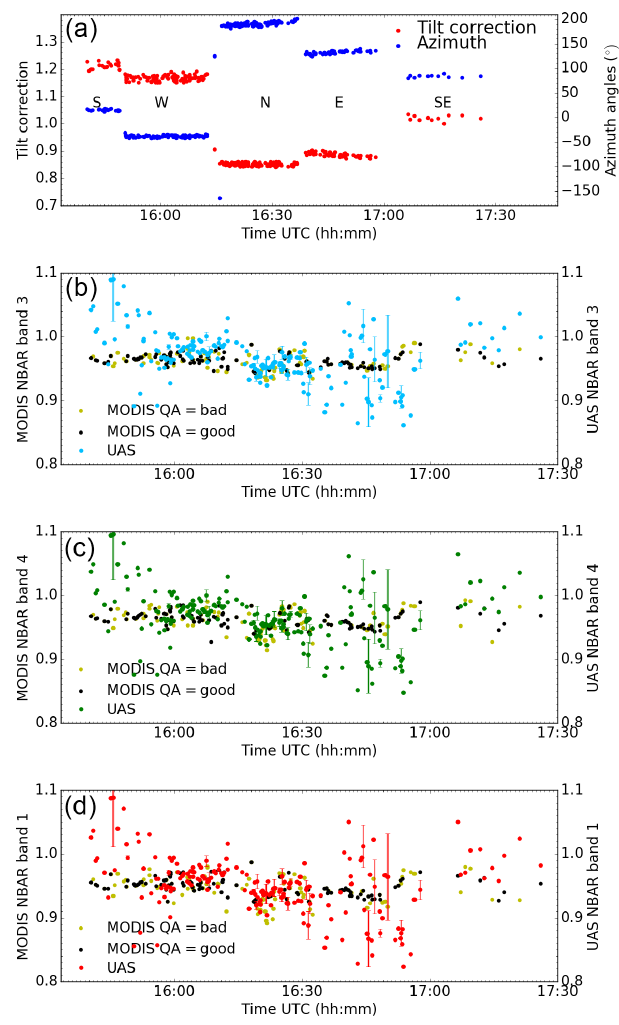
Figure 5. (a) The azimuth angle of the UAS (blue dots) and the tilt correction factor R l /R t , Eq. (3) (red dots). The various flight track elements are identified by letters and correspond to the flight tracks in Fig. 2. (b–d) The MODIS (black dots: good quality; yellow dots: low quality) and UAS band 3 (blue), 4 (green), and 1 (red) NBARs as a function of time. In the case of several UAS data points within one MODIS pixel, the UAS data have been grouped together and presented as a dot with standard deviation. All data from the flight on 5 August